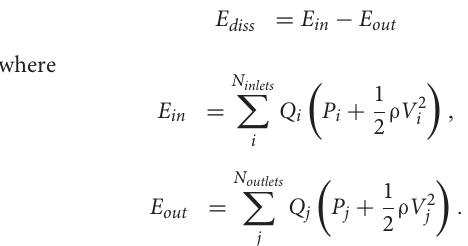
FIGURE 3 | Distribution of stiffness and thickness of the pre- and post-intervention models. The introduction the endograft blocks the fenestration, which was therefore excluded from the post-intervention